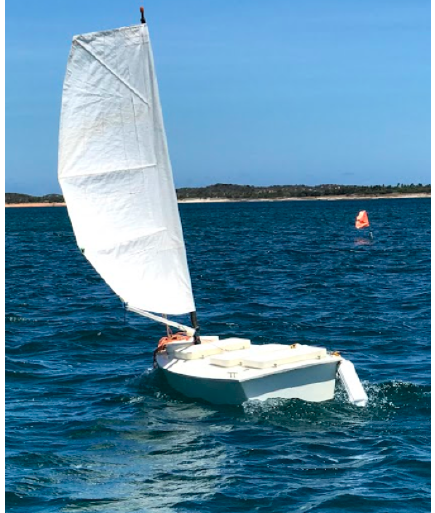
Figure 17. N-Boat the Sailboat Robot during the first field tests at the Bonfim Lake, Natal,